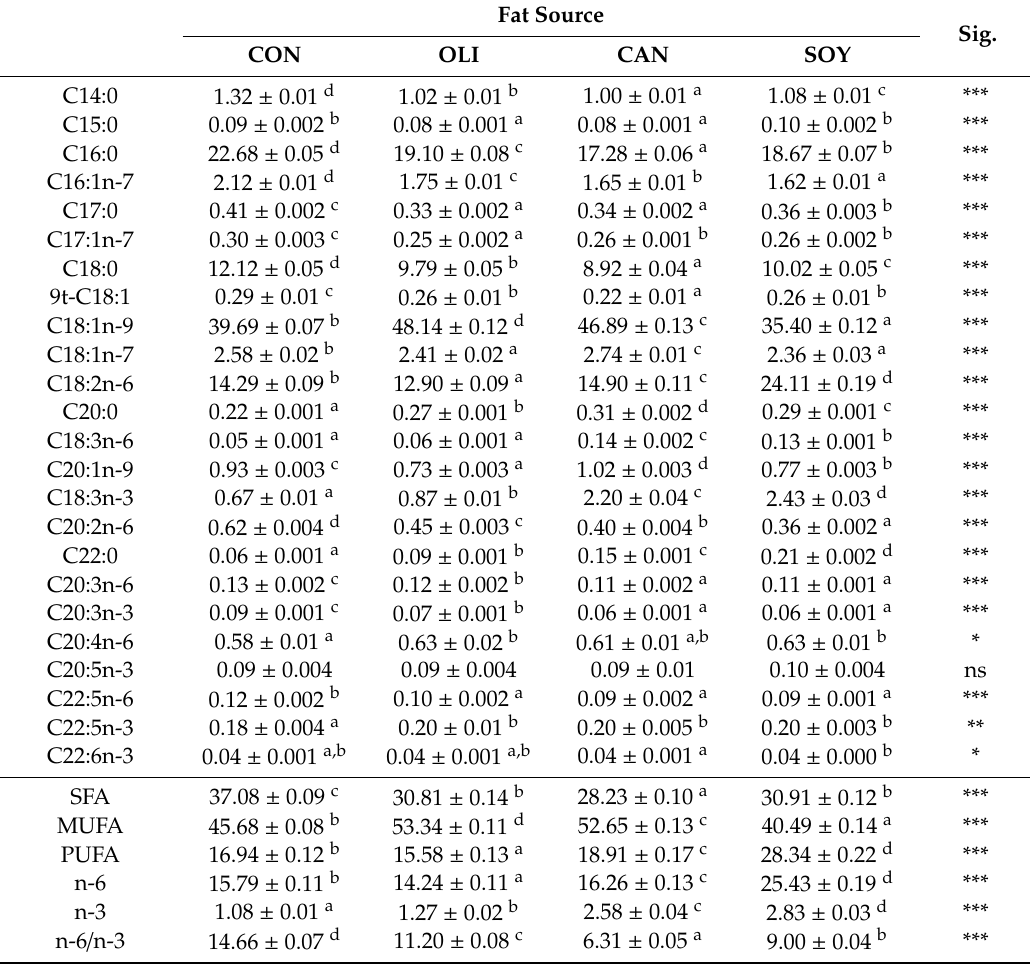
Table 3. E ff ect of fat source on fatty acid composition (expressed as g / 100 g of total fatty acids) of dry-fermented deer